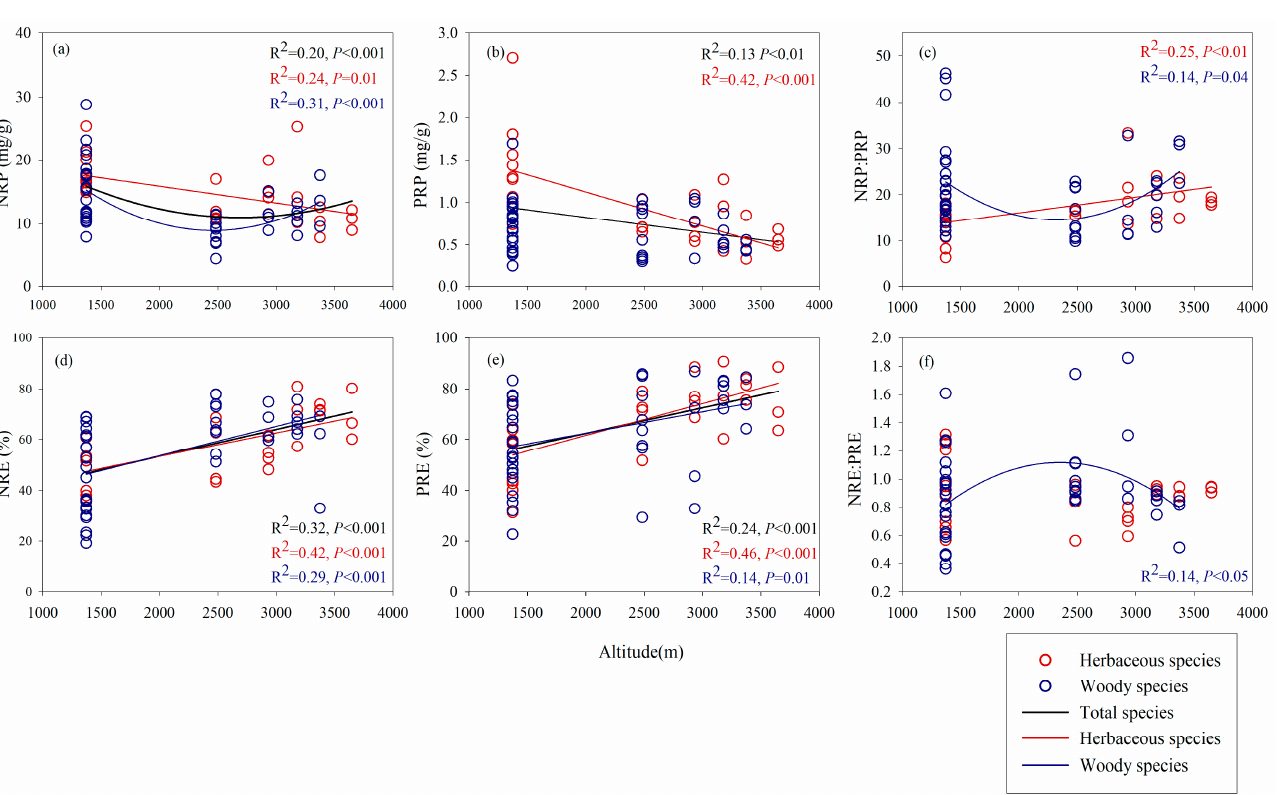
Table 2. Results of linear mixed-effects models for leaf N and P resorption traits.